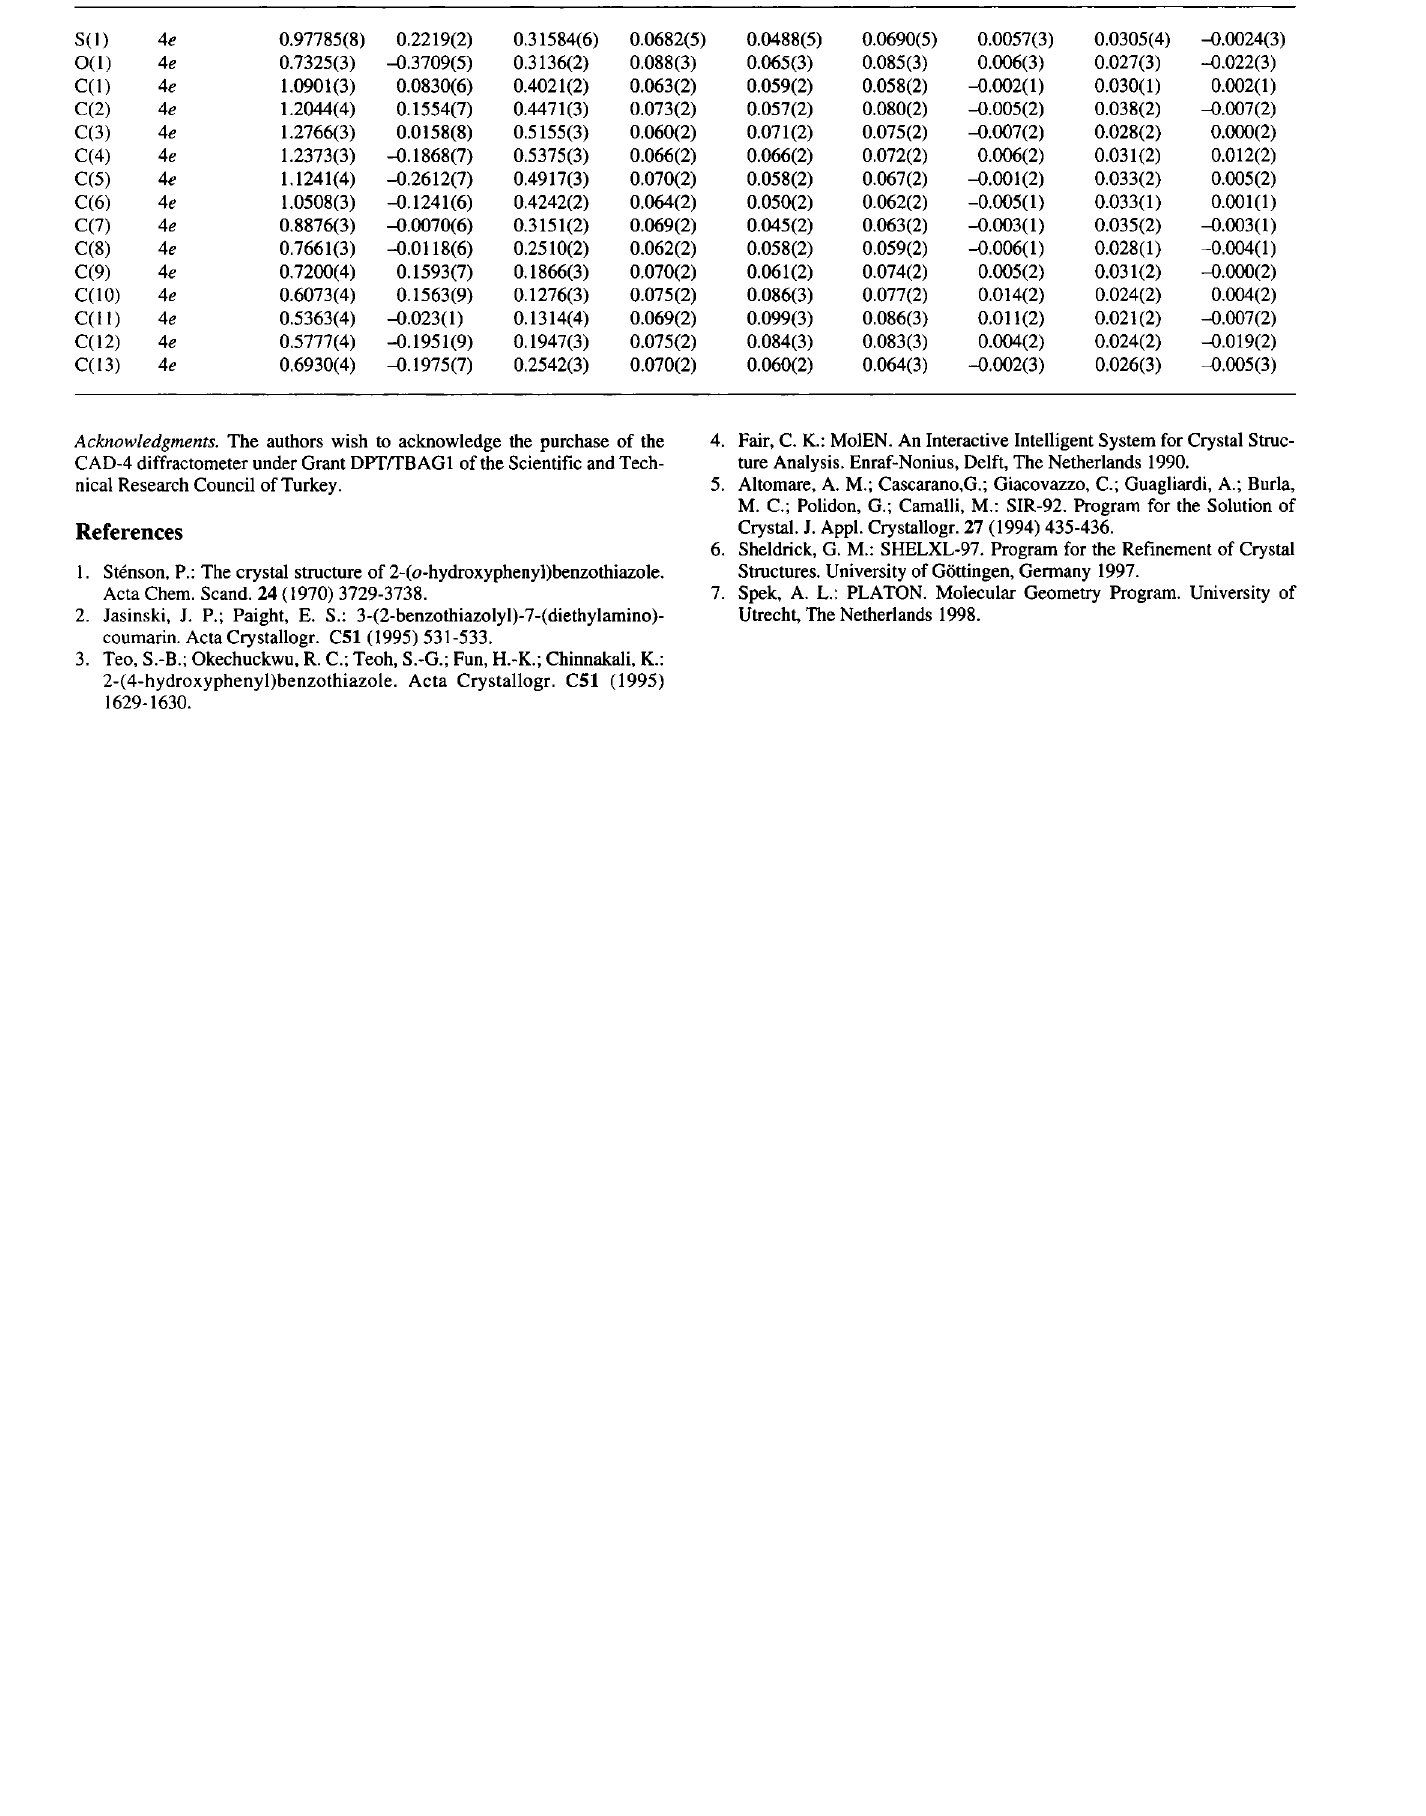
Table 3. Atomic coordinates and displacement parameters (in Ä 2